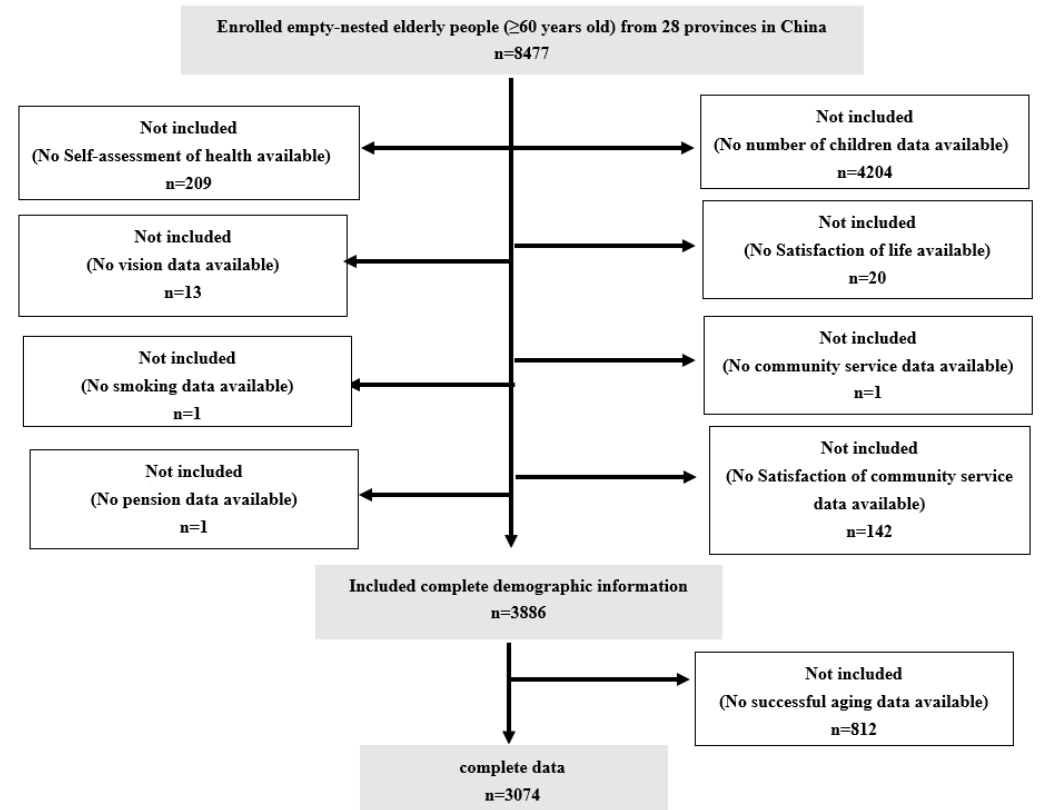
Figure 1. Sample selection Flowchart.